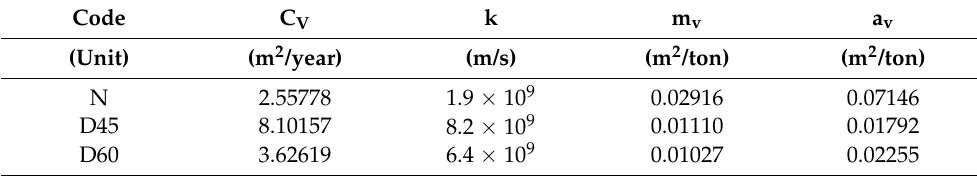
Table 6. Conducted and derived permeability and compression parameters for N, D45 and D60.